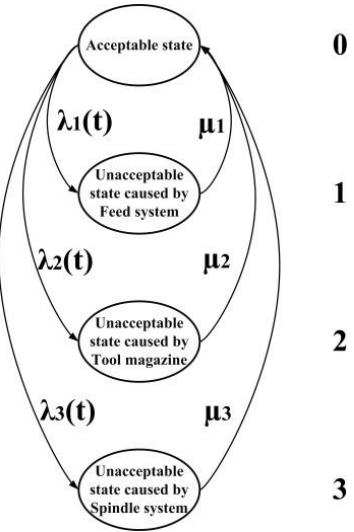
Figure 4. State transition diagram of CNC Machine